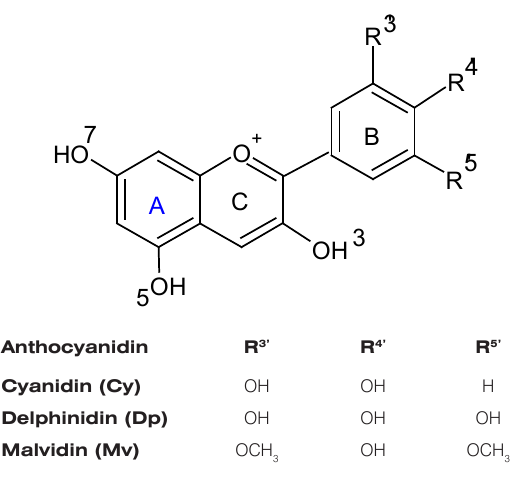
Figure 1. General structure of